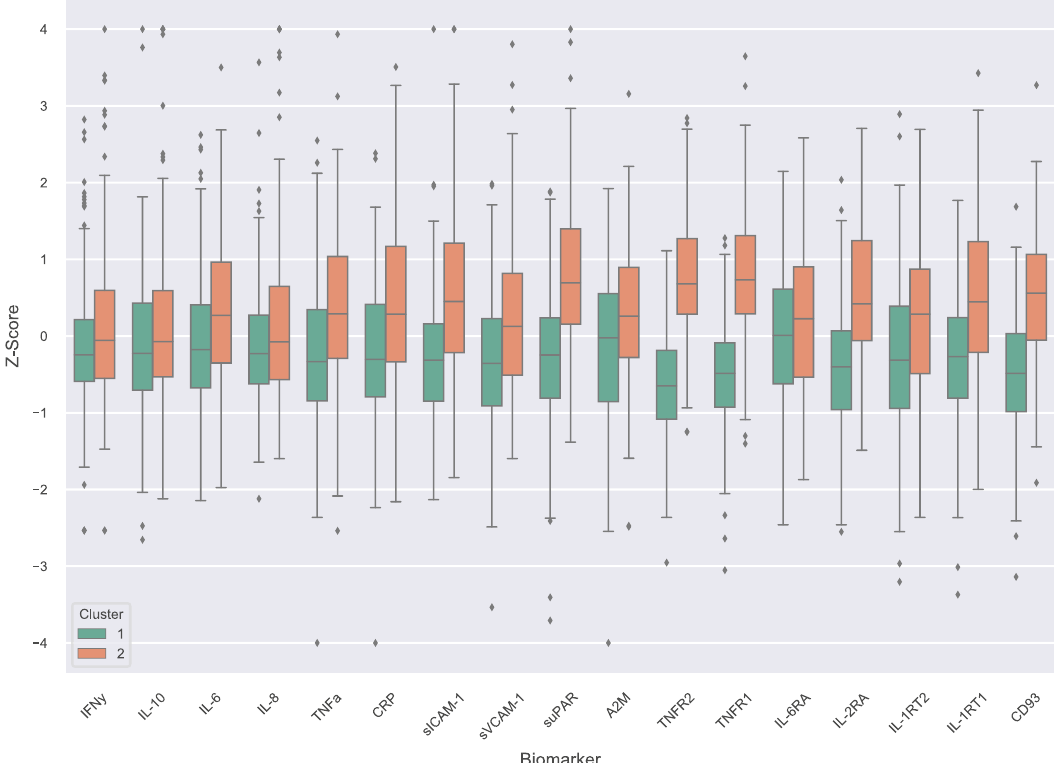
Fig. 2 Distribution of standardised in fl ammatory biomarker values in each cluster as determined by semi-supervised clustering. A consensus clustering solution across 100 subsamples was determined by the algorithm HYDRA, adjusting for sex and BMI. Simulation with the Sigclust method indicated that the clusters explained the data better than a Gaussian distribution ( p = 0.021). Interferon-gamma (IFN- γ ), interleukin-10 (IL-10), interleukin-6 (IL-6), interleukin-8 (IL-8), tumour necrosis factor-alpha (TNF- α ), C-reactive protein (CRP), soluble intracellular adhesion molecule-1s (ICAM-1), soluble vascular cell adhesion molecule-1 (sVCAM-1), soluble urokinase plasminogen activation receptor (suPAR), alpha-2-macroglobulin (A2M), tumour necrosis factor receptor 1 (TNFR1), tumour necrosis factor receptor 2 (TNFR2), interleukin-1 receptor type 1 (IL-1RT1), interleukin-1 receptor type 2 (IL-1RT2), interleukin-2 receptor subunit alpha (IL-2RA), interleukin-6 receptor subunit alpha (IL-6RA), cluster of differentiation 93 (CD93).